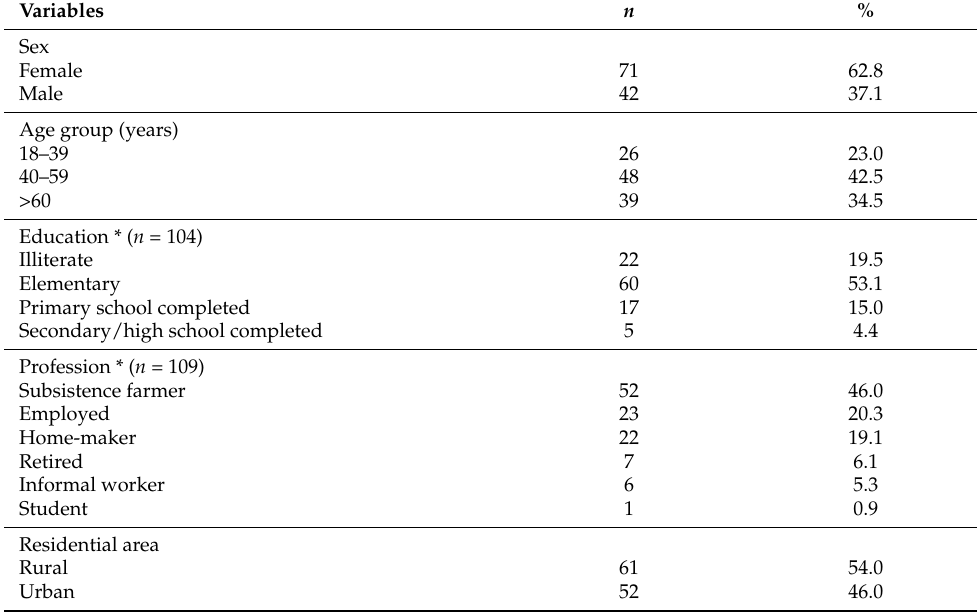
Table 2. Characteristics of study participants, Cear á , Brazil, 2019 ( n = 113).